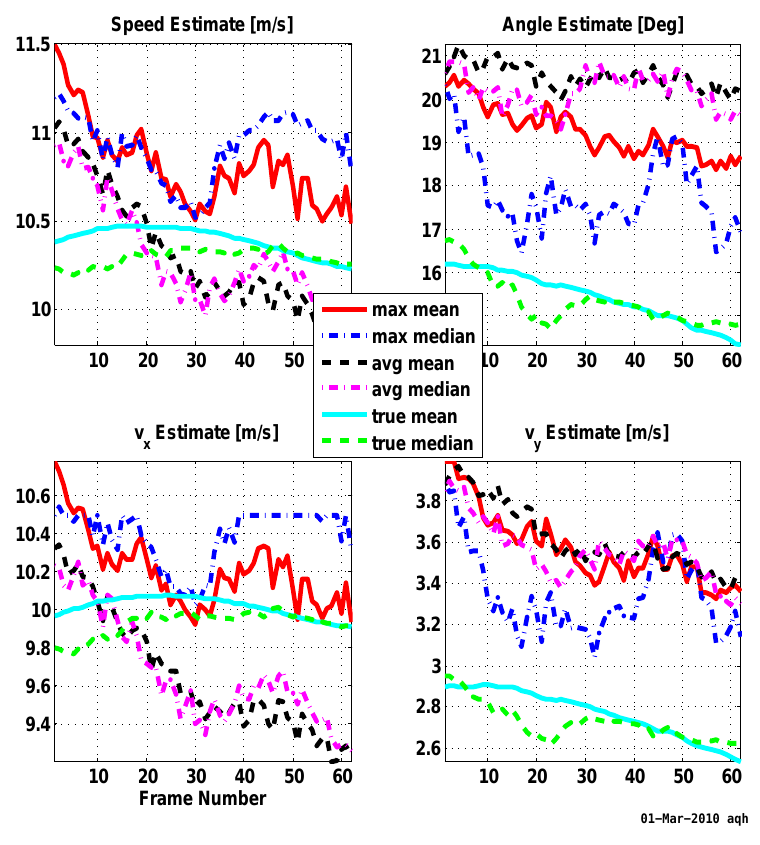
Associated summary of frame mean and median statistics for 64 time-lapse image